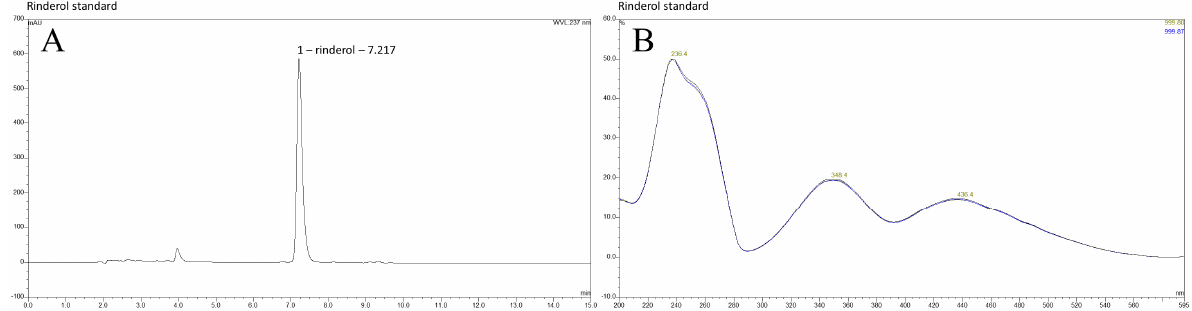
most productive R. graeca root line TR7 cultivated in vitro in PUF immobilized cultures; ( B ) rinderol specific spectrum of peak 16 confirming compound identification, λ = 237 nm.